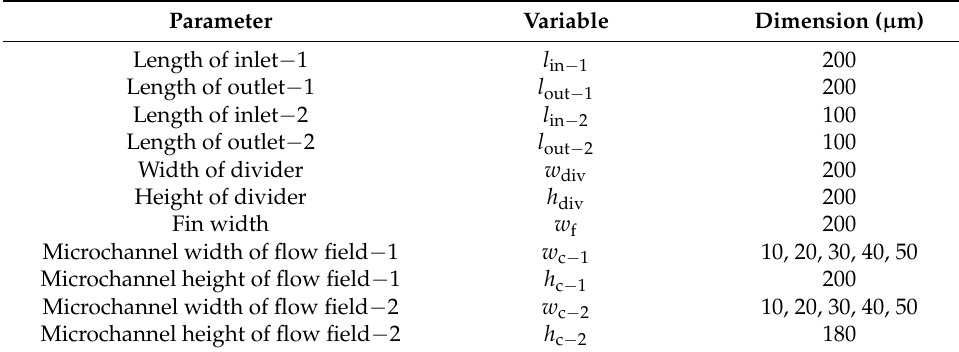
Figure 1. The schematic diagram of the MDMC heat sink. Table 1. The summary of the MDMC structure dimensions.